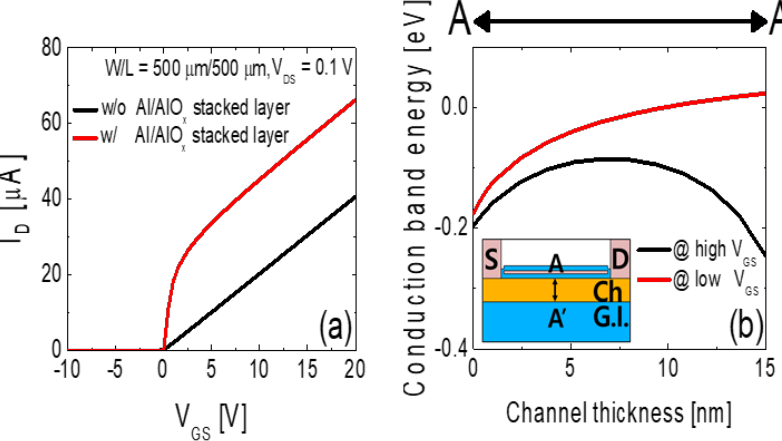
Figure 8. ( a ) Technology computer-aided design (TCAD) simulation results for the transfer characteristics of the IGTO TFT without and with an Al / AlO X stacked layer on top of the IGTO channel layer. ( b ) TCAD simulation results for the conduction band energy in the IGTO TFT with an Al / AlO X stacked layer along A-A’ in the inset figure.